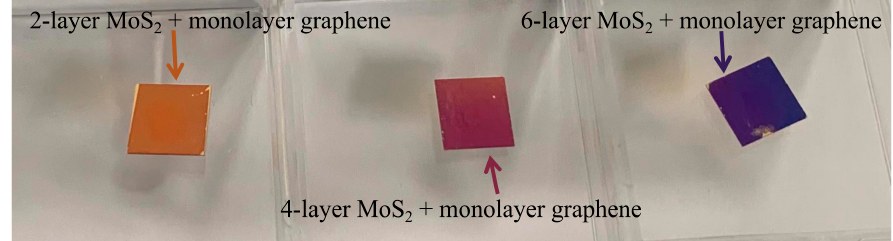
Figure 7. Photograph of the fabricated graphene–MoS 2 hybrid-structure sensor with different layers of MoS 2 and monolayer graphene.